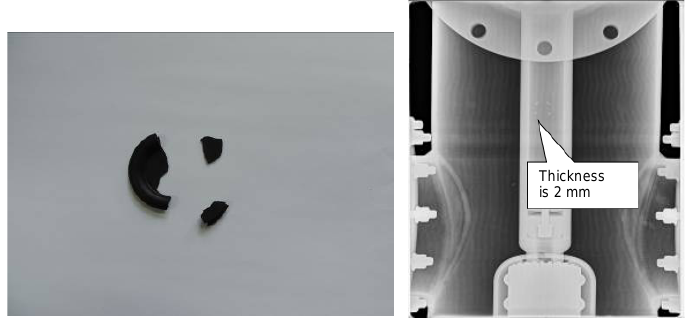
Figure 10. Non-metallic flaky